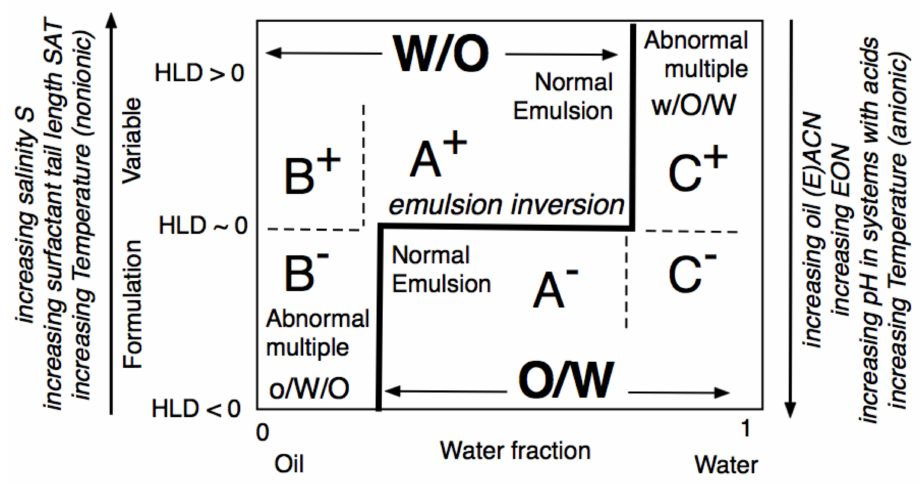
Figure 16. Classical formulation-composition diagram (HLD-WOR) showing the inversion line and emulsion